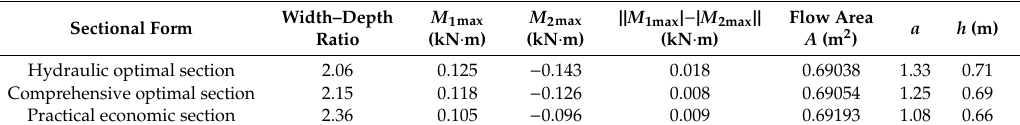
Table 2. Three types of channel section parameters.